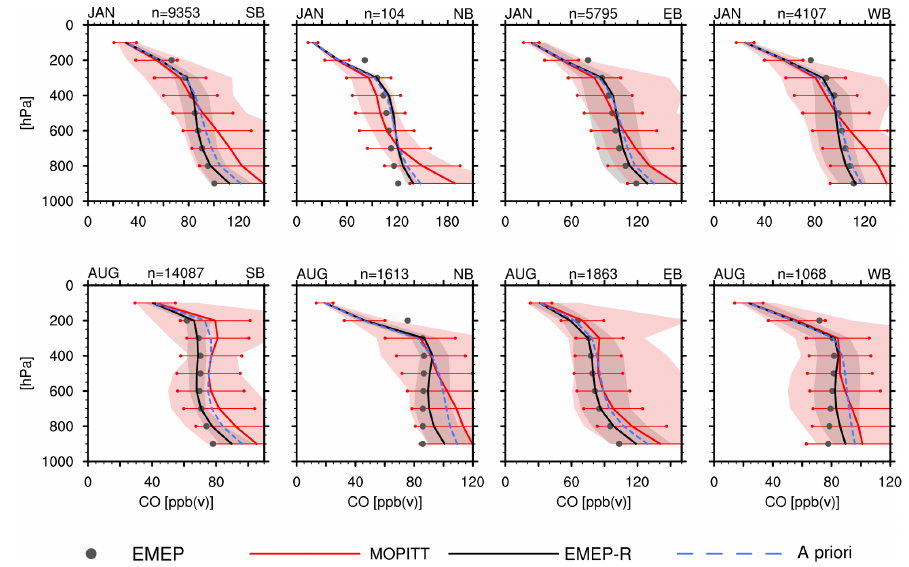
Figure 2. Carbon monoxide mixing ratios for January (first row) and August (second row) at the four cardinal boundaries (denoted SB, NB, EB, and WB), observed by MOPITT (red solid line) and simulated retrievals from EMEP (black solid line). The retrievals (EMEP-R) are calculated by using Eq. (1) with EMEP model data (grey dots) and applying MOPITT’s averaging kernel and adding the a priori profile (blue dashed line). The red and grey shaded area correspond to the range of values in which the satellite and retrieval values vary at each level. The satellite uncertainties are represented by the red horizontal lines.